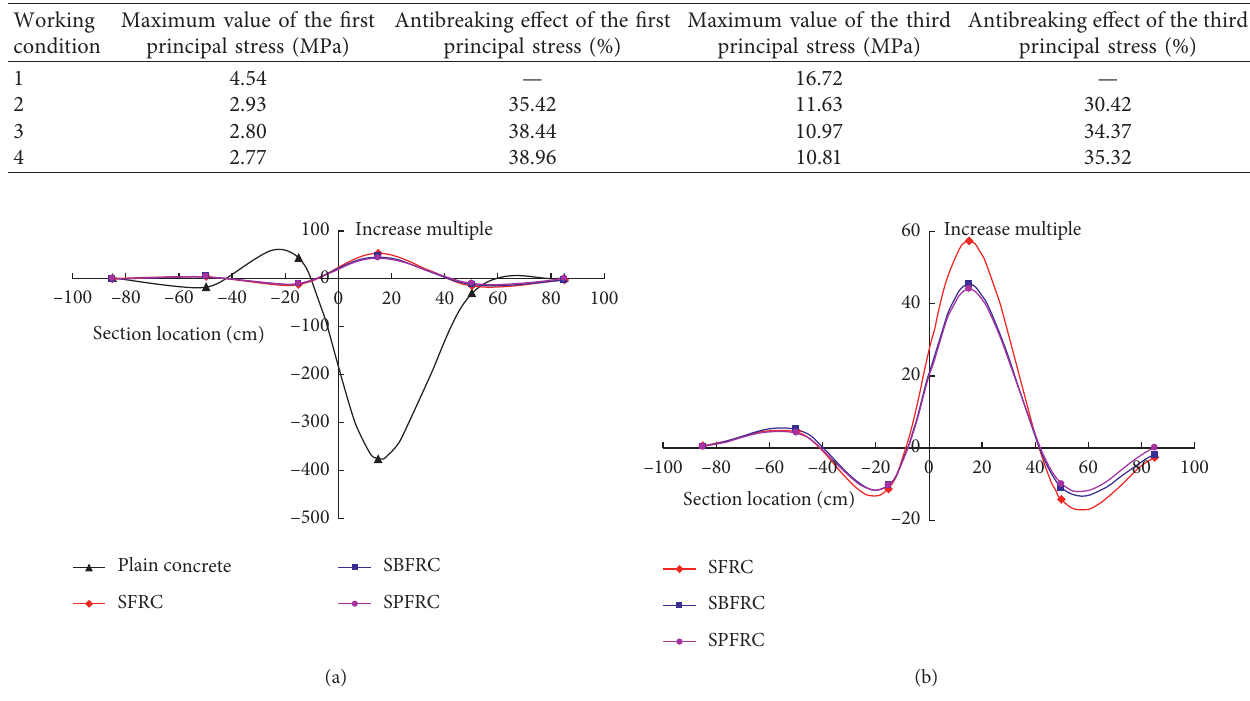
Table 8: Antibreaking effect of principal stress.